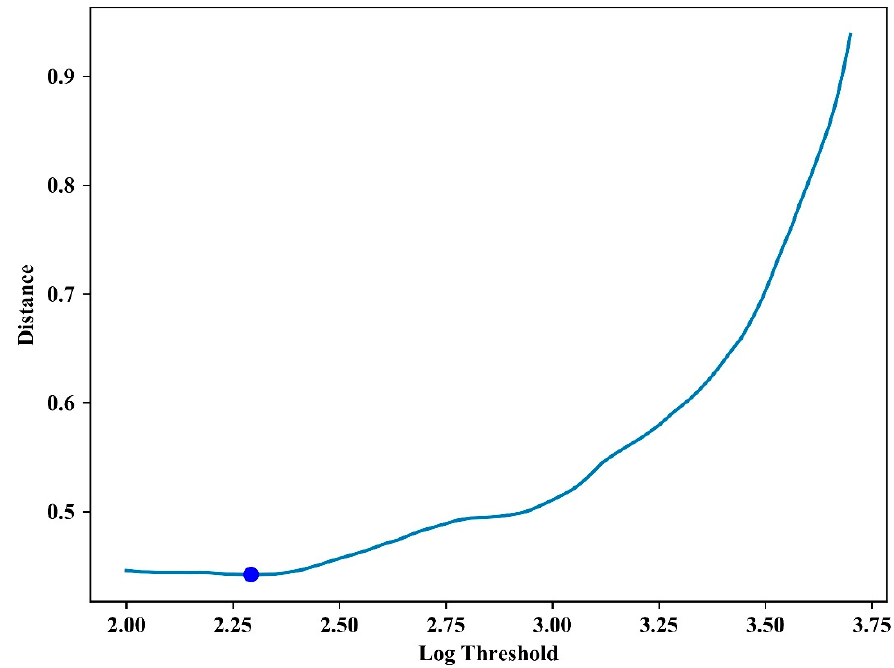
Figure 11. Distance distribution according to the log threshold for all experiments after calibration.